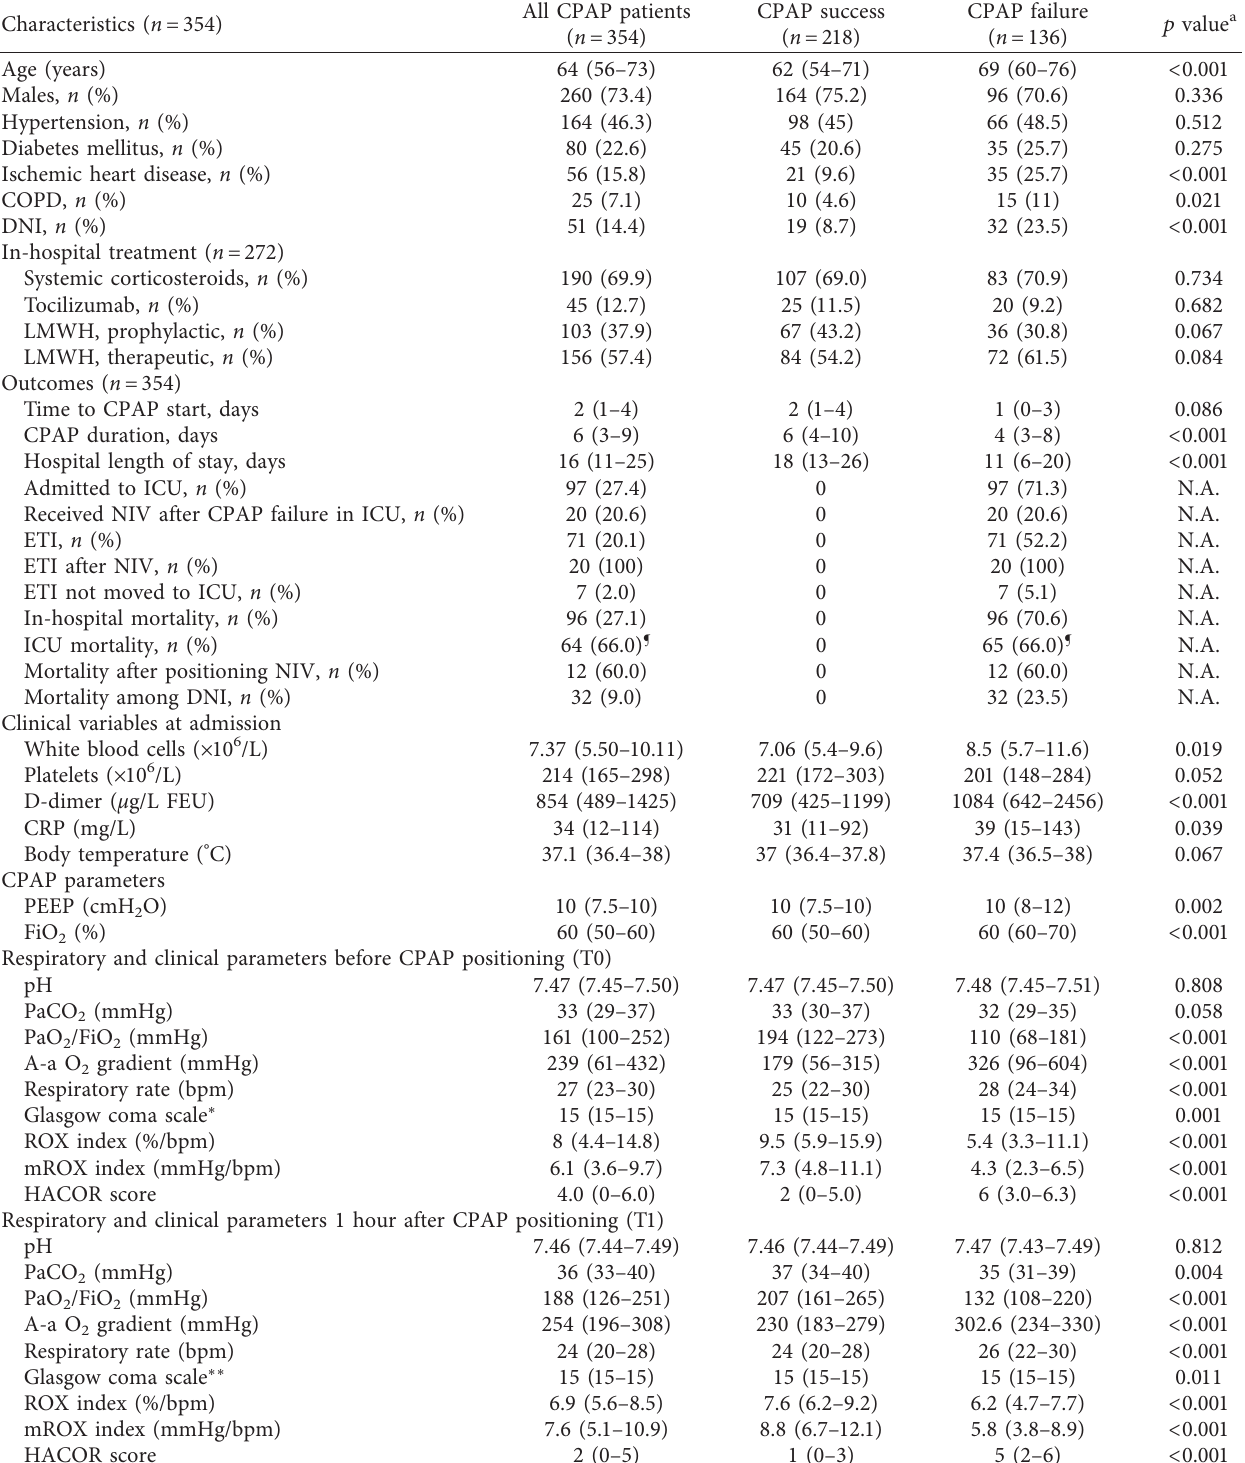
Table 1: Clinical characteristics at admission and after CPAP positioning and predictors of CPAP